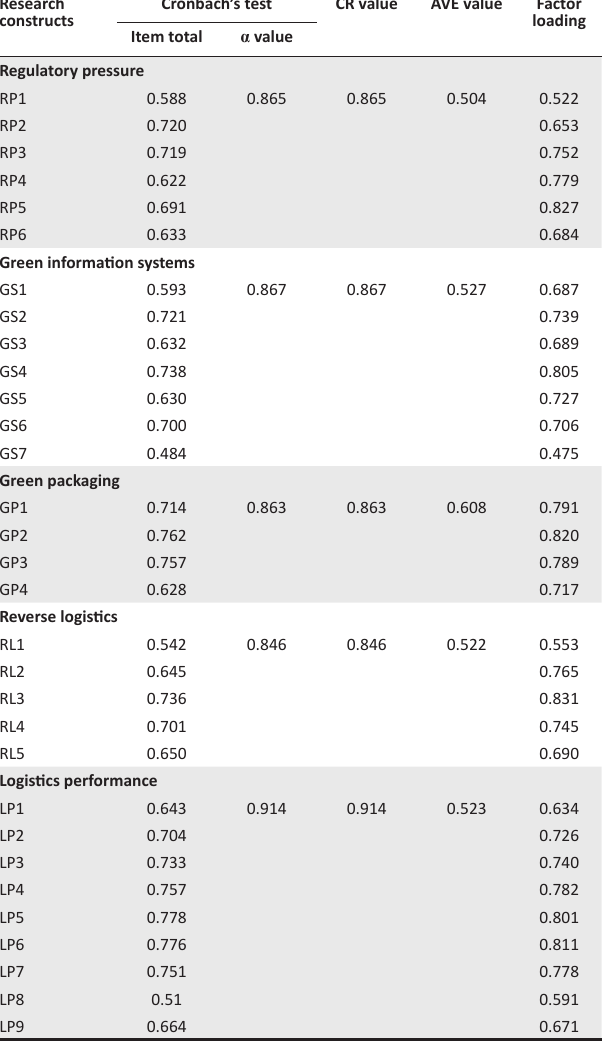
TABLE 1: Scale accuracy analysis. Research constructs